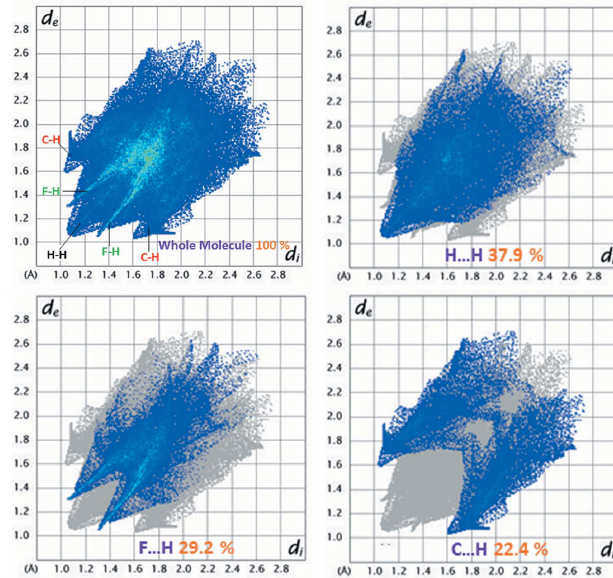
Figure 3 A view of the C11—H11 (cid:2)(cid:2)(cid:2) (cid:2) interaction (intramolecular). Some of the atoms have been omitted for clarity.